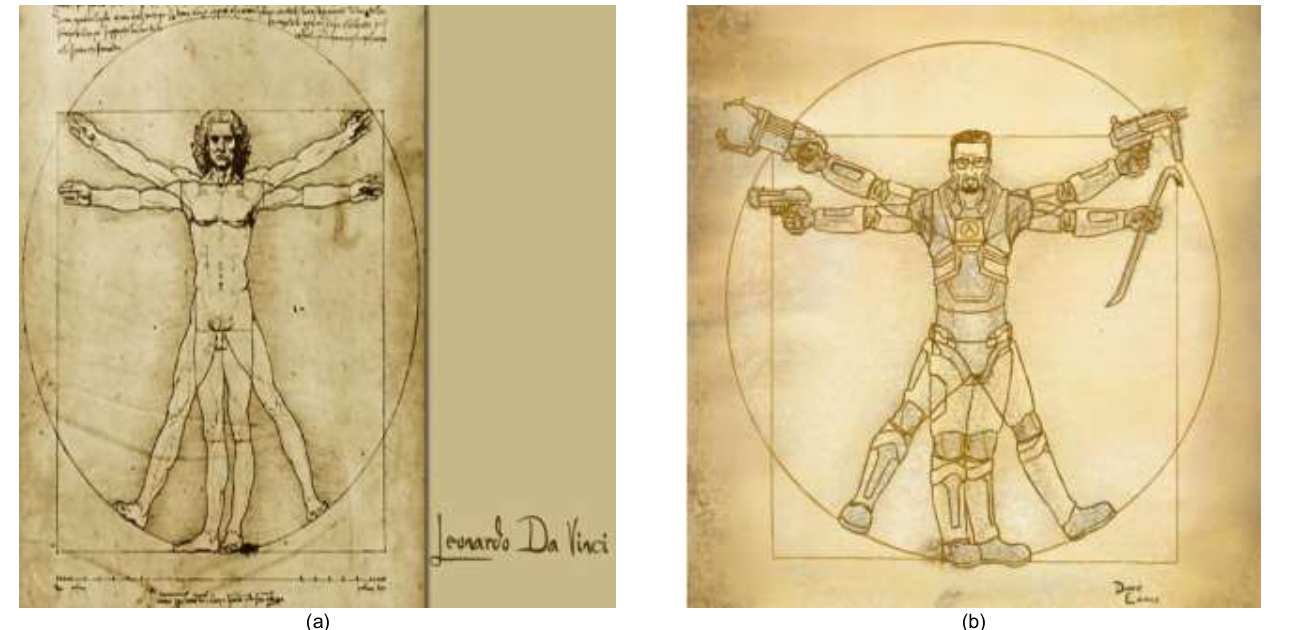
Figure 1 . Vitruvius Man (a) by Leonardo Da Vinci [6] and Gordon Freeman (b) by Dave Eames